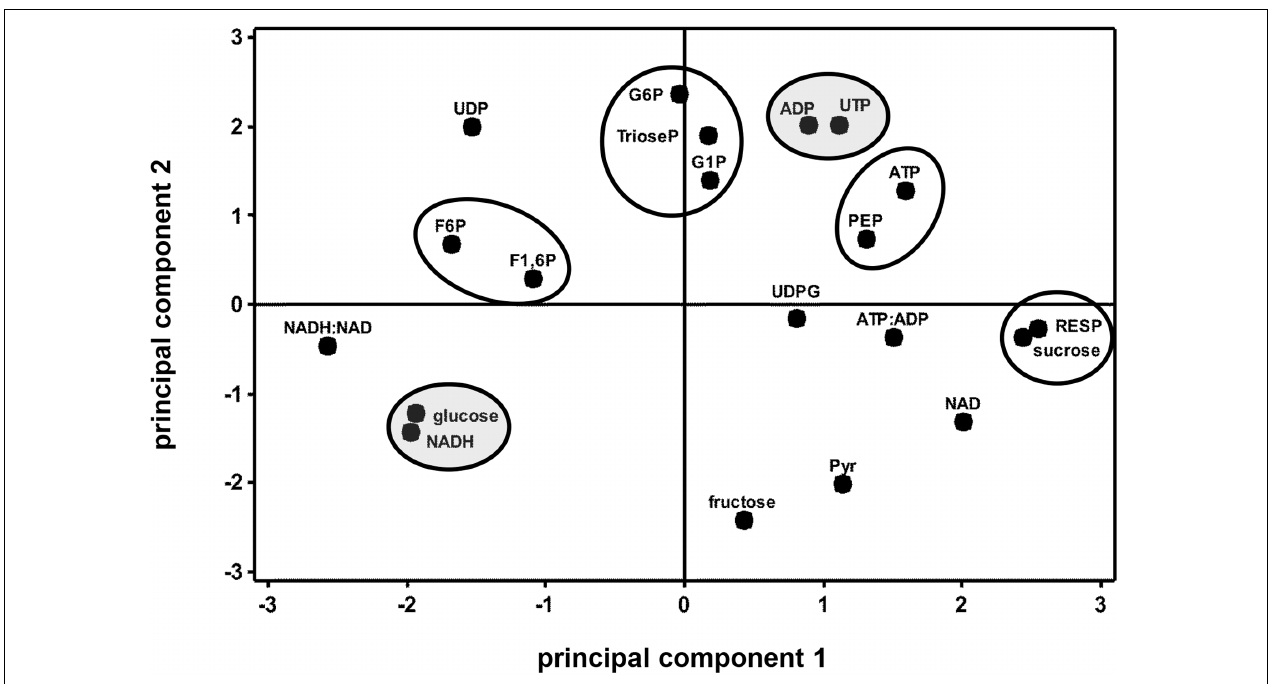
FIGURE 5 | Principal component analysis score plot of the changes in glycolytic pathway metabolite concentrations, ATP:ADP ratio, NADH:NAD + ratio, and respiration rate (RESP) during 60 days storage. Ovals identify groups of metabolites that exhibit similarities in storage-related concentration changes. Ovals are gray where metabolites share similar changes in concentration, but have no obvious connection with each other. Roots were stored 10 days at 10 ◦ C and 90 ± 5% RH, then stored at 4 ◦ C, 90 ± 5% RH for 50 days. Principal components 1 and 2 account for 34 and 30%, respectively, of the variance in the data after standardization. Abbreviations used for metabolites are defined in Table 3 . PCA loading plot is available in Supplementary Figure S2.